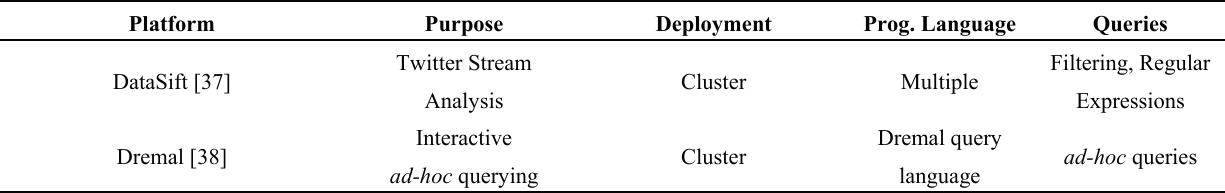
Table 3. Large-scale